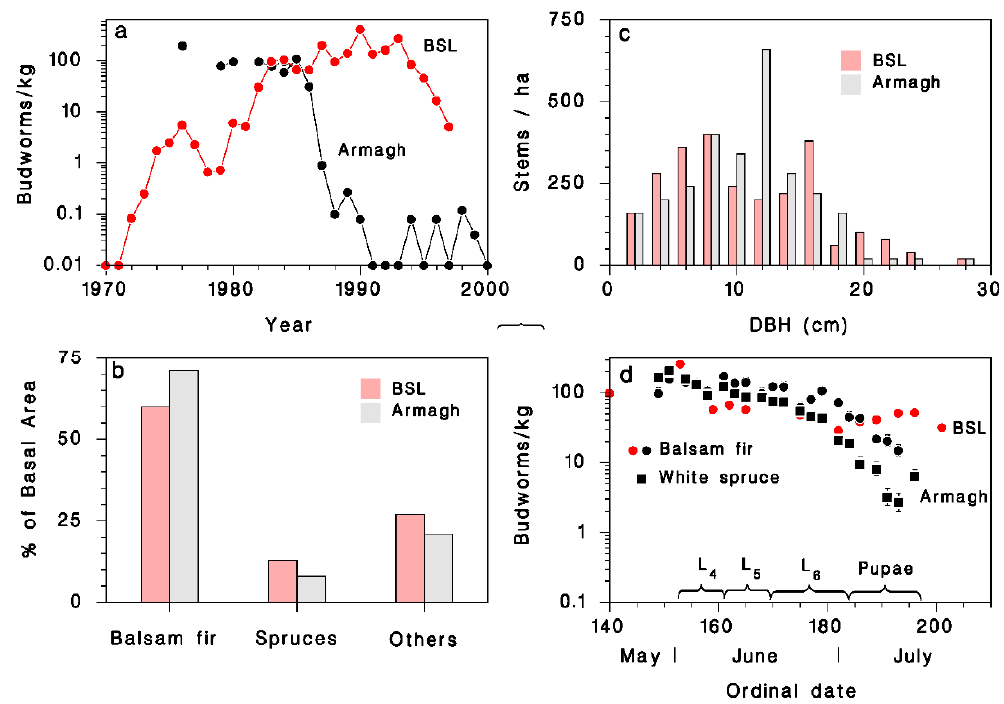
Figure 1. History of budworm outbreaks and description forest stands at Black Sturgeon Lake (BSL) and Armagh. ( a ) Population density at the 4th instar (BSL: red; Armagh: black). ( b ) Basal area of balsam fir, spruces (white and black), and other species. ( c ) Distribution of balsam fir diameters at breast height (DBH, cm). ( d ) Budworm population density during their summer development at BSL on balsam fir in 1983 (red) and on balsam fir and white spruce in Armagh in 1985 (black). Seasonal development of budworm is indicated along the date axis in ( d ). Data from [12,28].